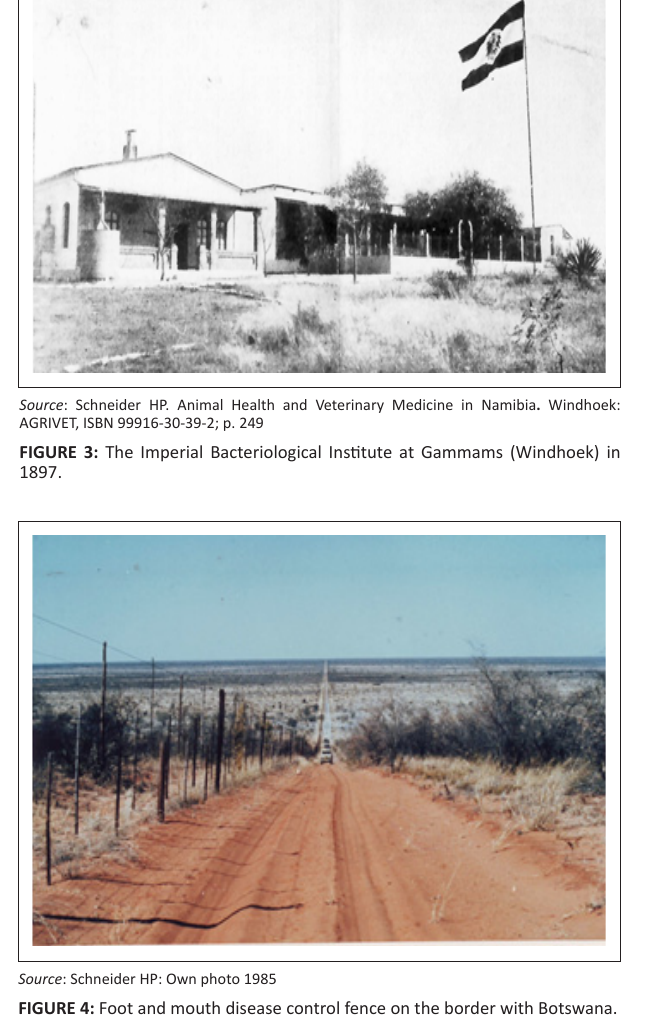
FIGURE 4: Foot and mouth disease control fence on the border with Botswana.